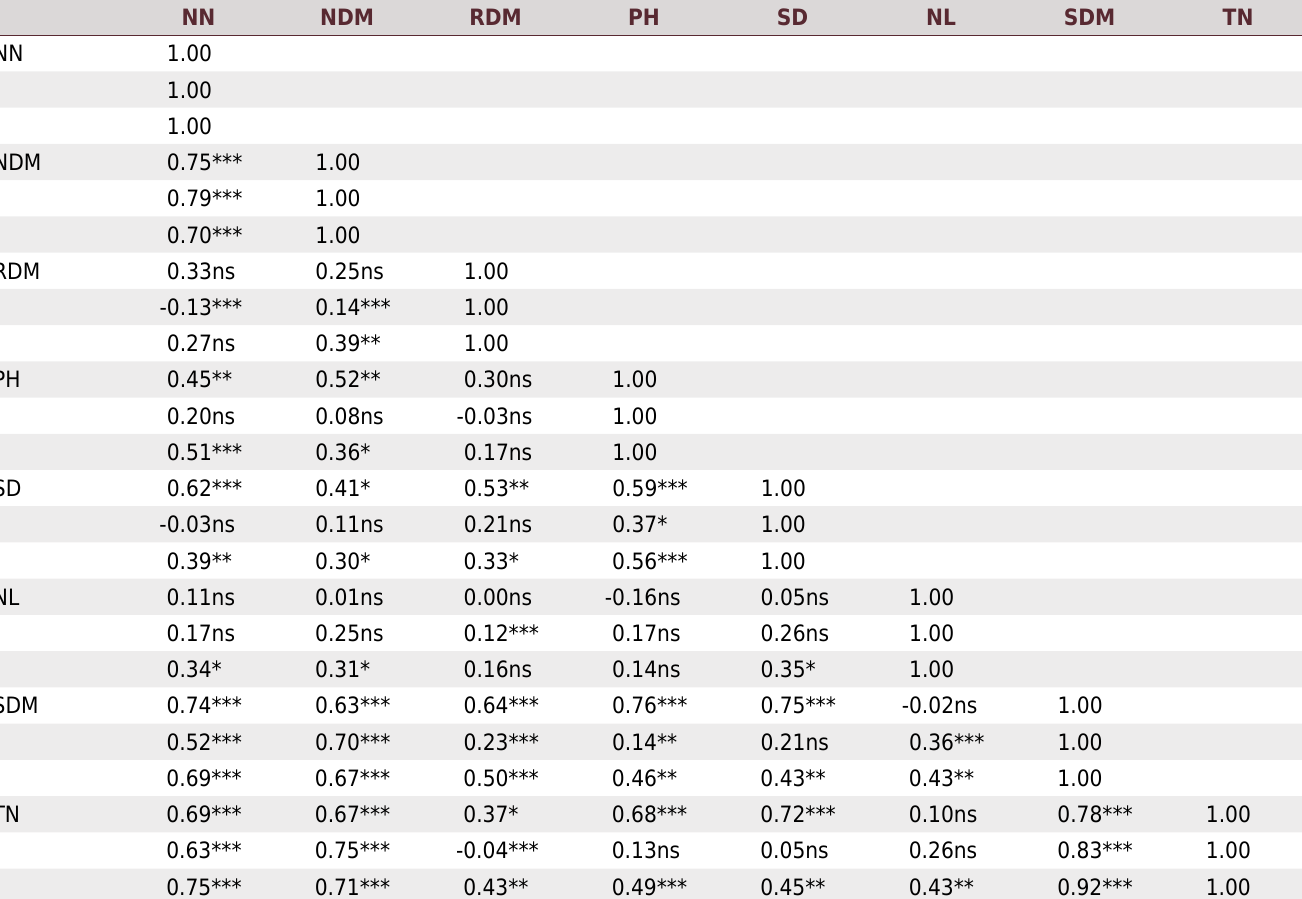
Table 4. Matrix of Pearson correlation ( r ) of variables utilized in the three experiments of symbiotic effectiveness of Bradyrhizobium ingae inoculated in Inga edulis Mart. seedlings NN